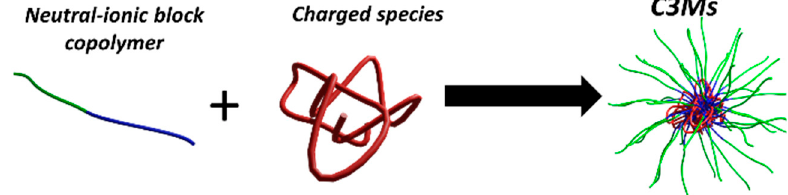
Figure 1. Schematic representation of the formation of complex coacervate core micelles (C3Ms) from a neutral-ionic block copolymer and an oppositely charged species in aqueous solution.